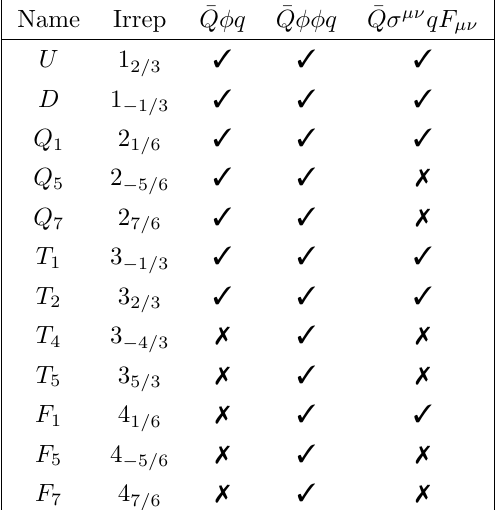
(cid:2) U(1) Table 1 . Irreps (2 T + 1) under SU(2) and linear interactions of new quarks with Y L Y dimension-5 linear couplings. The subscript in the name of each multiplet is the absolute value of the numerator of its hypercharge, when written as an irreducible fraction. An explicit formula for this integer number is j 2 + 4 e T + 3( Y (cid:0) 2 = 3) = (1 (cid:0) e T ) j where e T = T (mod